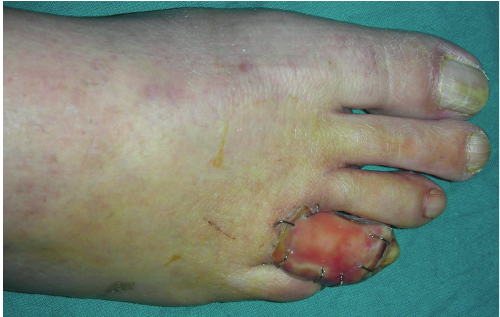
Figure 2: Immediate postop: reconstruction of the forth digit with the dermal regeneration template (Integra).